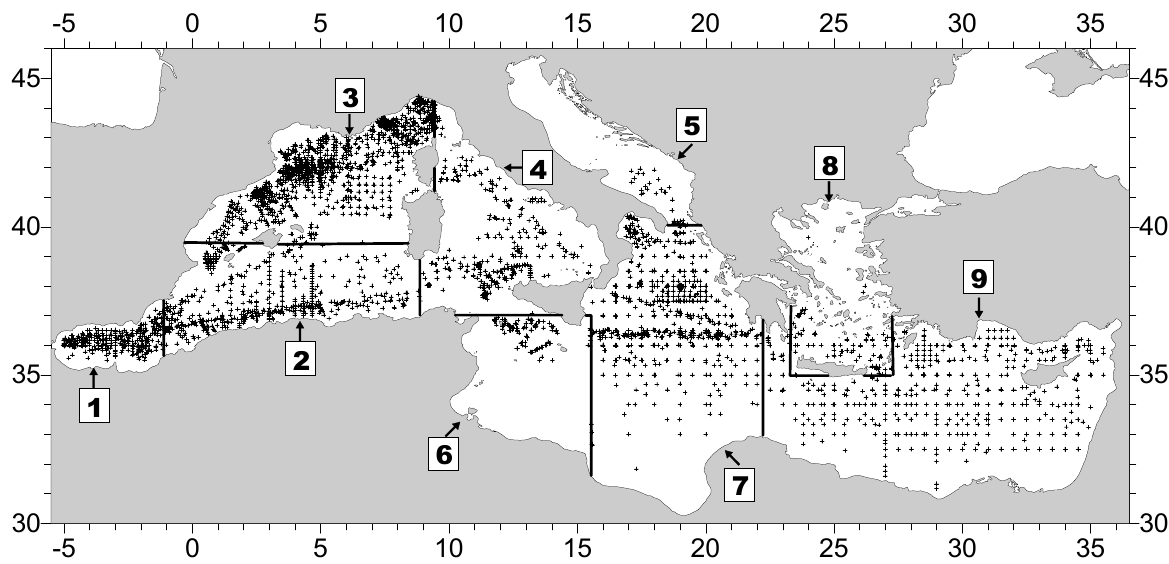
Fig. 1. Regional breakdown of the Mediterranean Sea with the positions of Medatlas casts indicated by crosses in the plot. The regions are the following: (1) Alboran Sea; (2) Algerian Basin; (3) northwestern Basin; (4) Tyrrhenian Sea; (5) Adriatic Sea; (6) Strait of Sicily; (7) Ionian Sea; (8) Aegean Sea; (9) Levantine